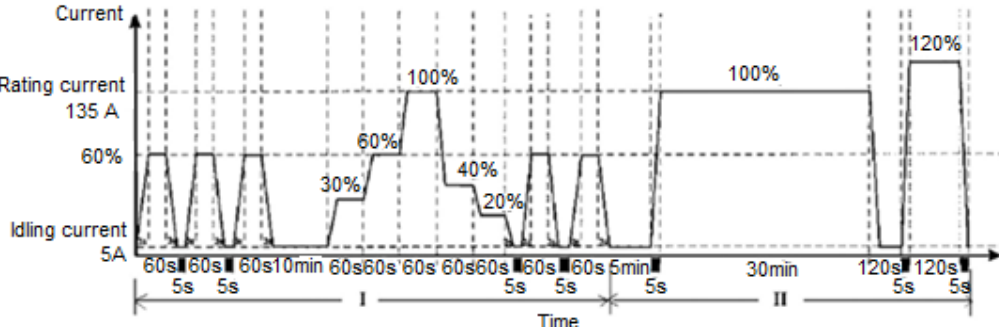
Figure 10. Tsinghua University test protocol [4] (Reproduced with permission from Huicui et al. [4], Applied Energy; published by Elsevier Ltd., 2018).